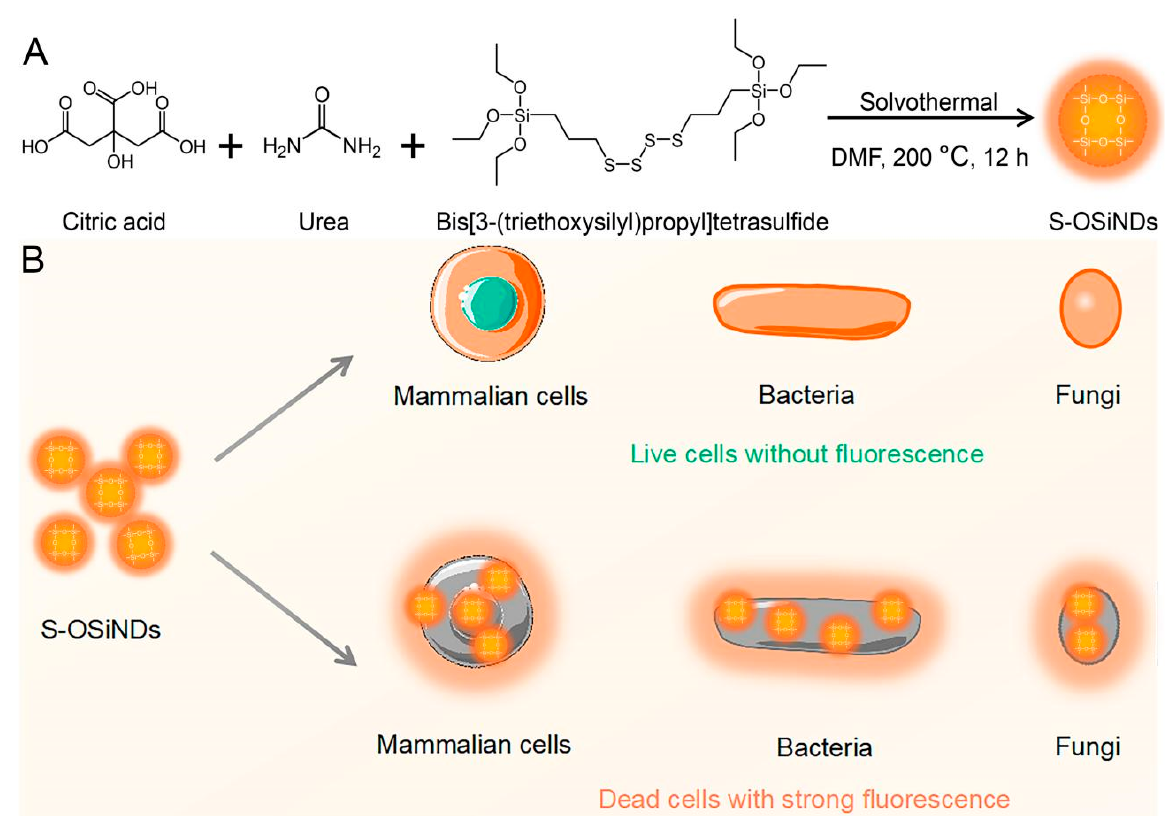
Scheme 1. Scheme depicting ( A ) the synthesis of S-OSiNDs and ( B ) their application for the discrimination between live and dead cells.